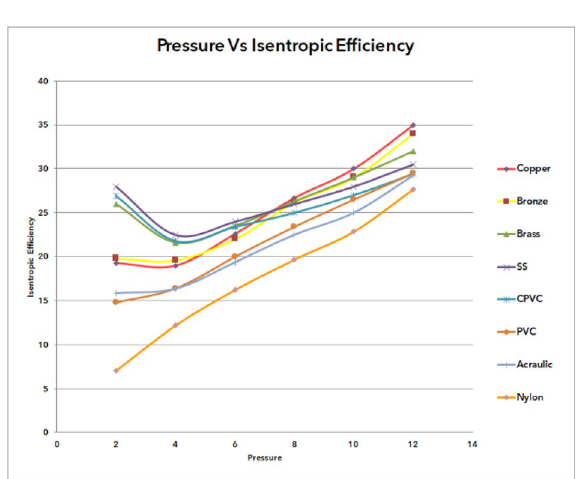
Figure 67. Pressure vs adiabatic efficiency.